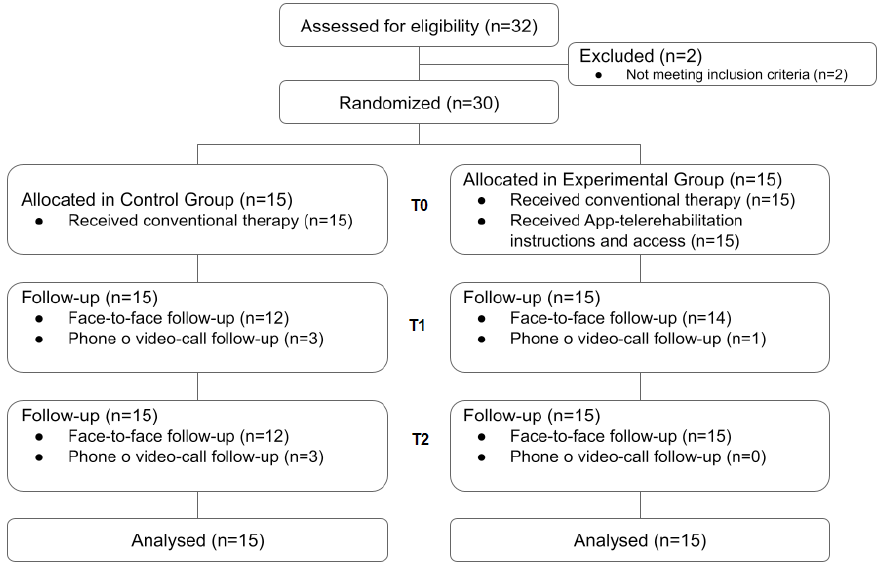
Figure 2. Flowchart of the study. Table 1. Characteristics of the experimental and control group at